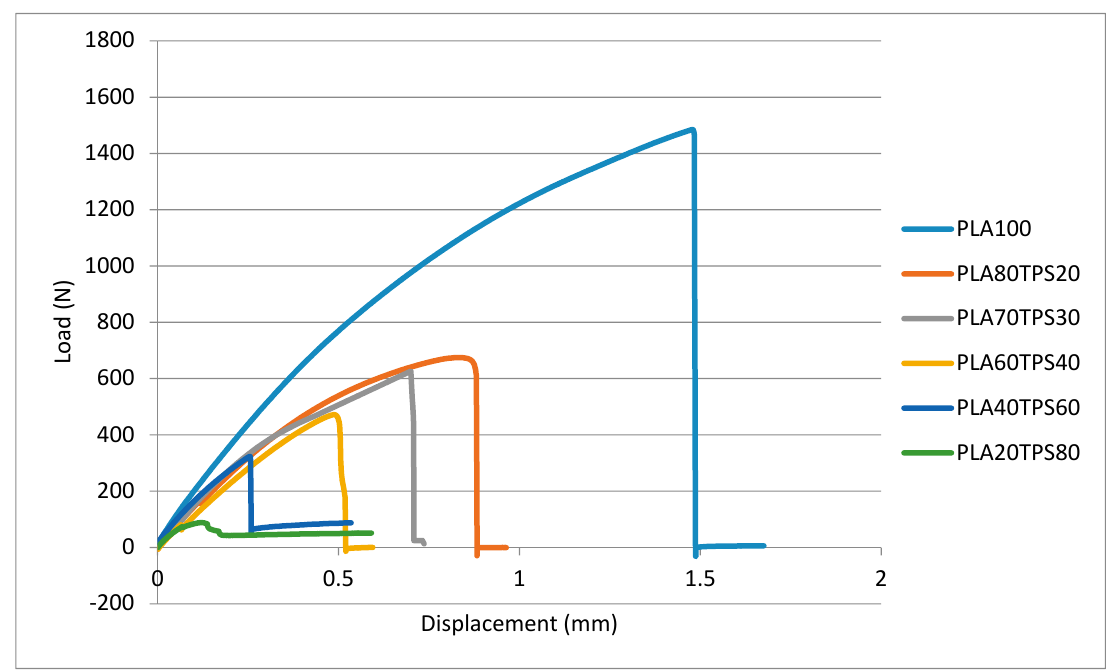
Figure 5. Tensile load–displacement curves of PLA100 and PLA/TPS blend bionanocomposites.